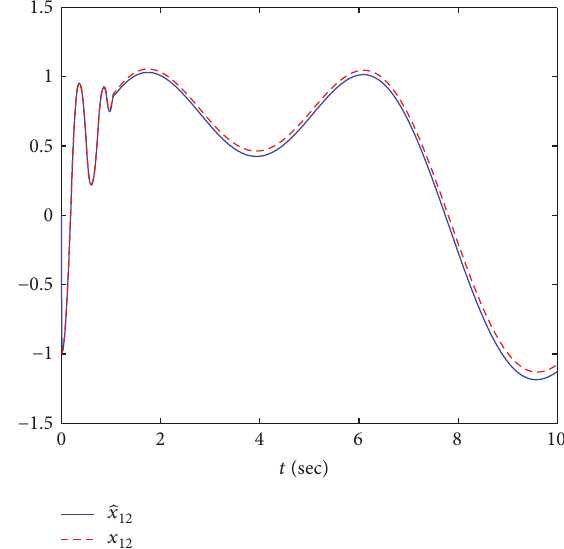
Figure 5: Responses of 𝑥 12 and its estimate.